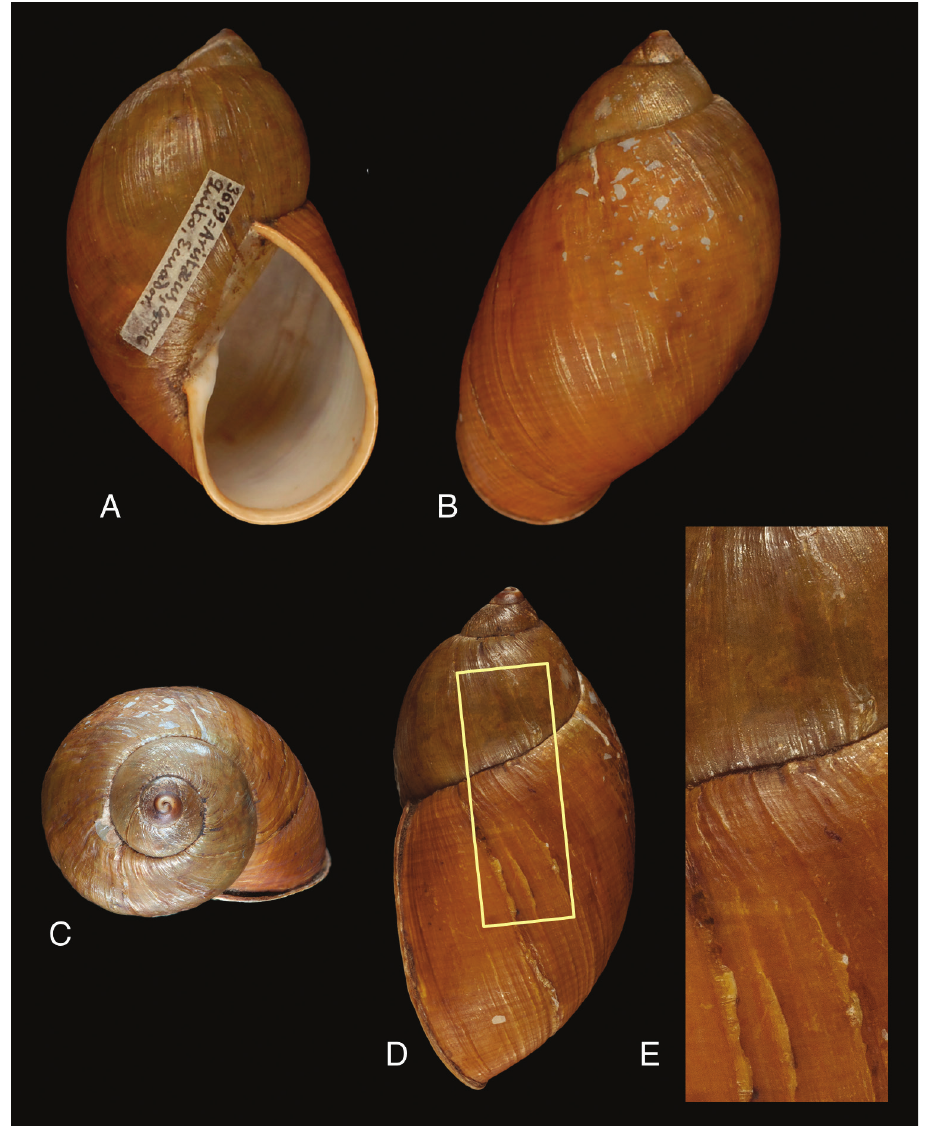
Figure 1. Plekocheilus ( Eurytus ) aristaceus (Crosse, 1869), lectotype MNCN 15.05/7180 (H = 48.3).